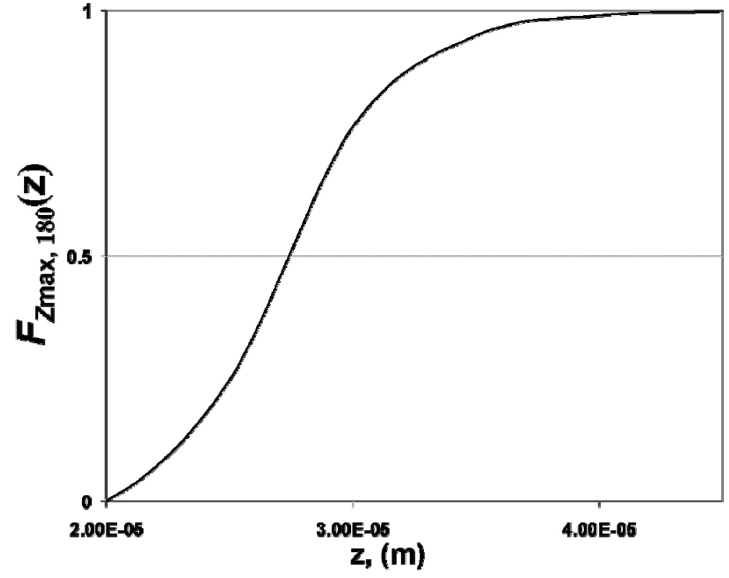
Fig. 9. CDF of extreme values corresponding to the response of Prototype M